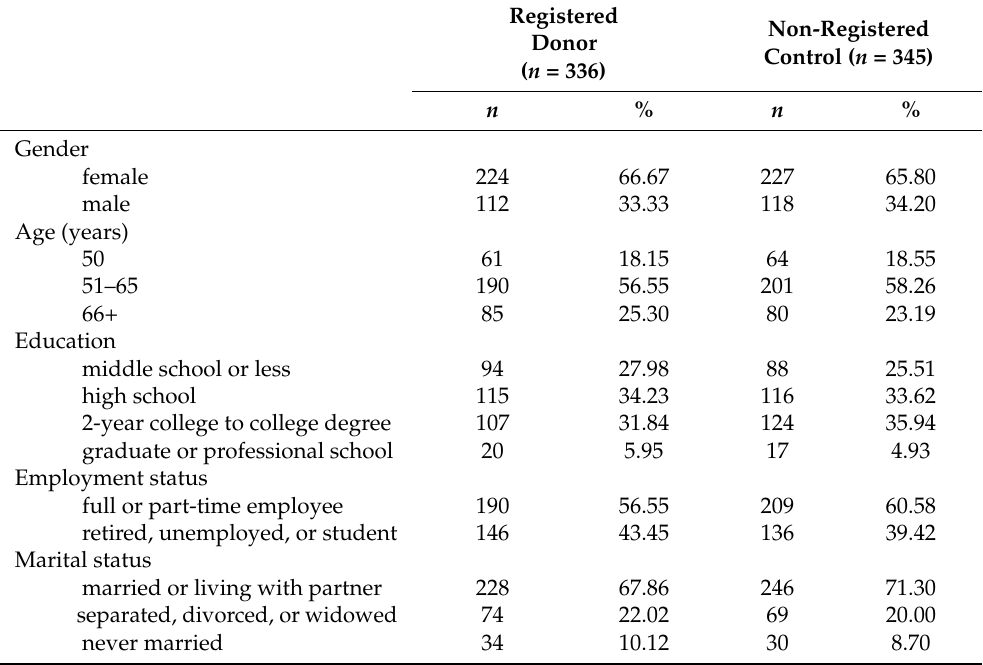
Table 1. Demographic characteristics of the two